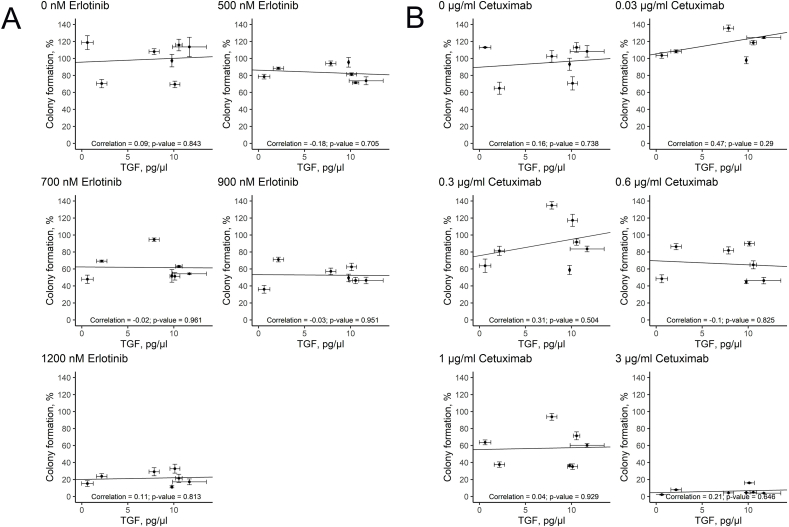
Dependence of colony formation efficacy by A431 cells treated with erlotinib (A) or cetuximab (B) on the presence of human donor serum samples, and concentration of TGFa in the respective serum samples. The data are shown as the mean of three independent replicates ± standard deviation.